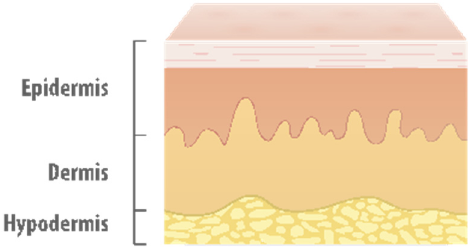
Figure 2. Layers of the skin